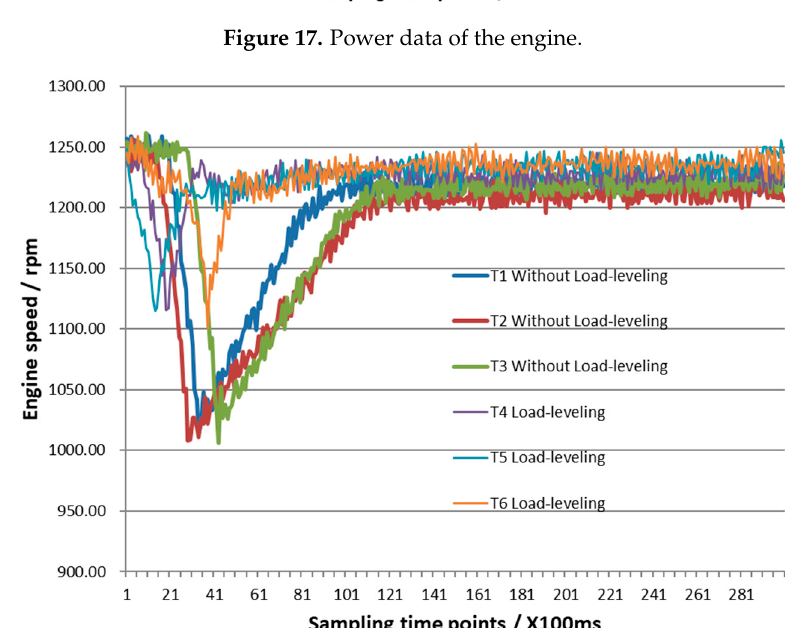
Figure 18. Speed data of the engine.